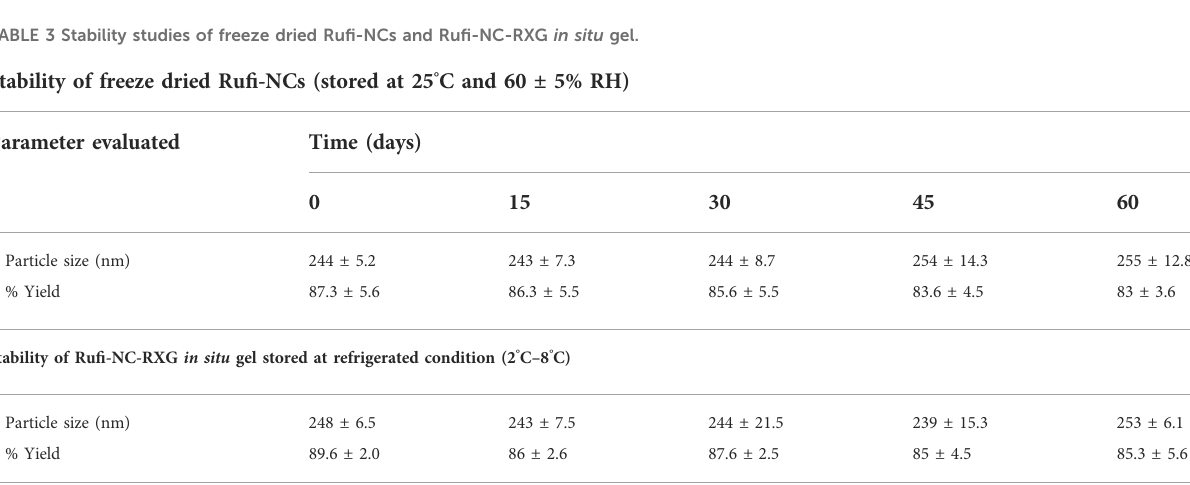
TABLE 3 Stability studies of freeze dried Ru fi -NCs and Ru fi -NC-RXG in situ